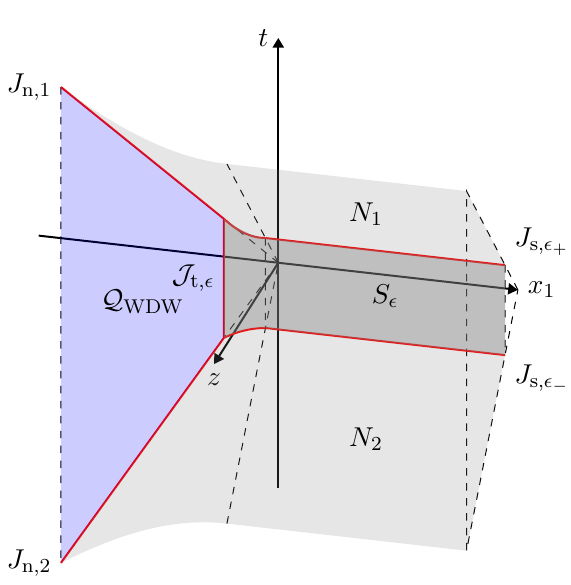
Figure 3 . The WDW patch which is the causal development of the Cauchy slice t = 0. The bulk region B WDW is surrounded by a portion Q WDW of the brane Q , null surfaces N 1 ; 2 and the timelike surface S (cid:15) at z = (cid:15) . The red lines are joints J n ; 1 ; 2 = N 1 ; 2 \ Q WDW , J s ;(cid:15) J t ;(cid:15) = Q WDW \ S (cid:15) . The other timelike surface S 1 at z = z 1 , the other spacelike joints J s ; 1 the other timelike joint J t ; 1 are not